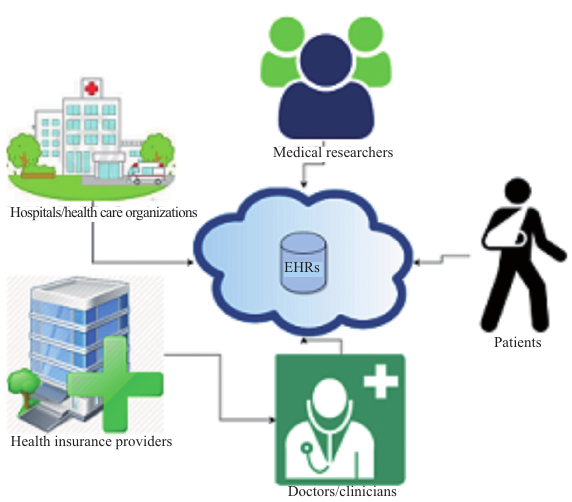
Fig. 1. Secure e­health cloud model using